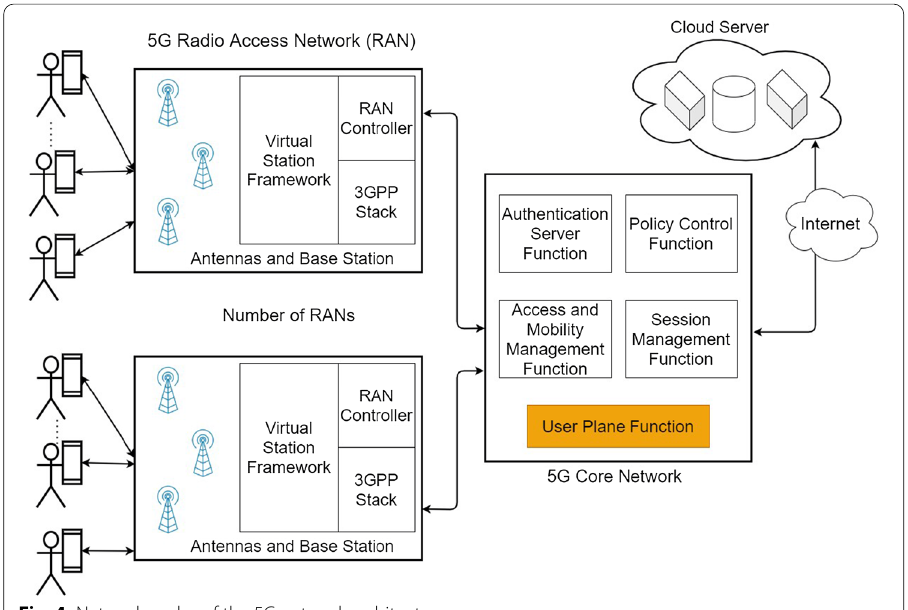
Fig. 4 Network nodes of the 5G network